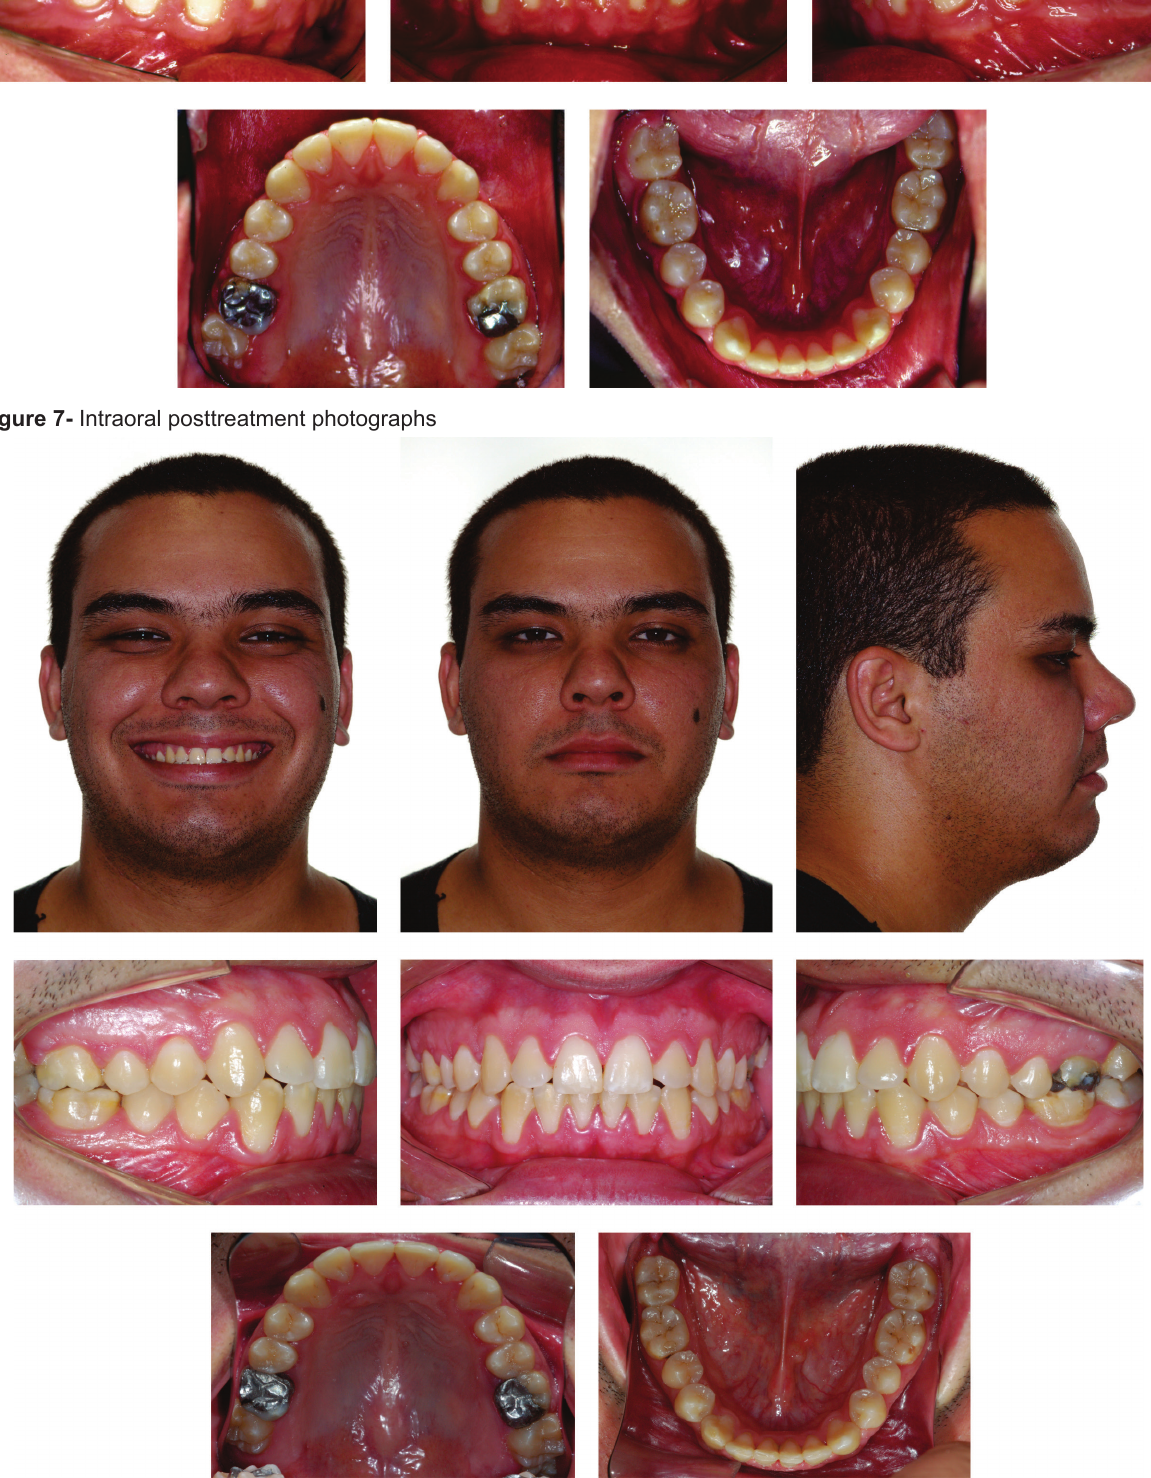
Figure 8- Extra-oral and Intraoral long-term posttreatment photographs. Parents authorized the publication of these